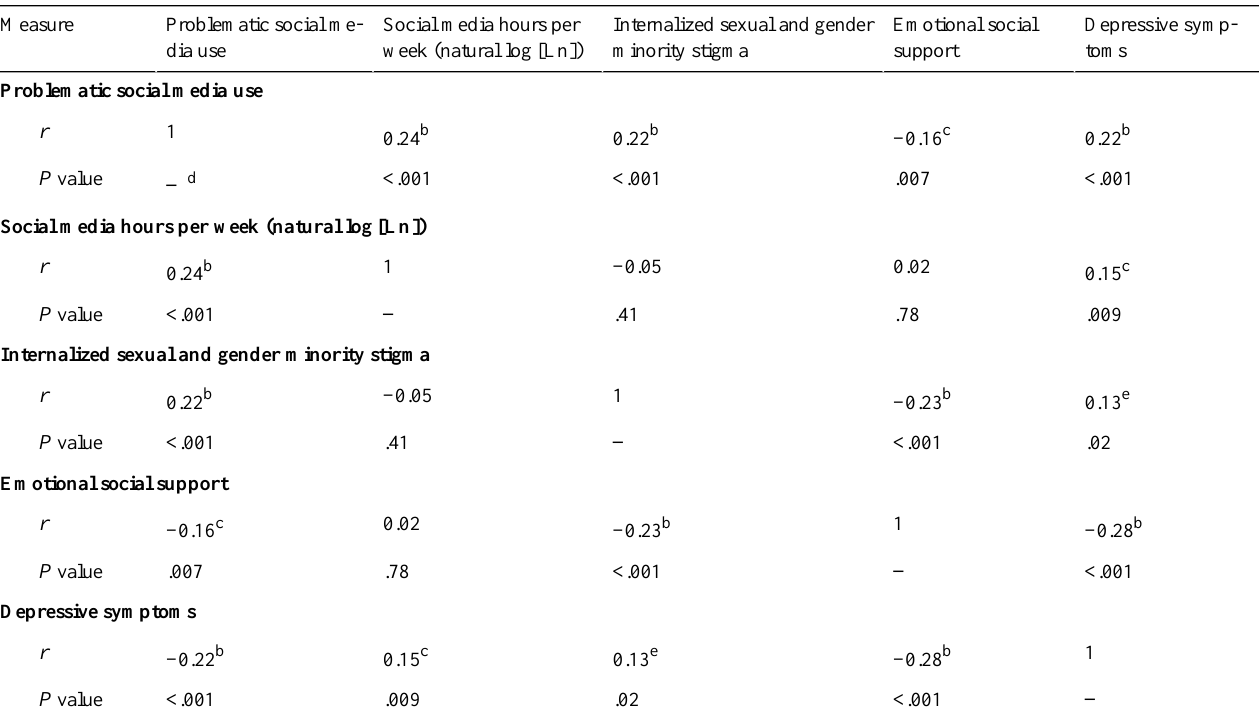
Table 3. Pearson correlations between key variables (N=302) a .